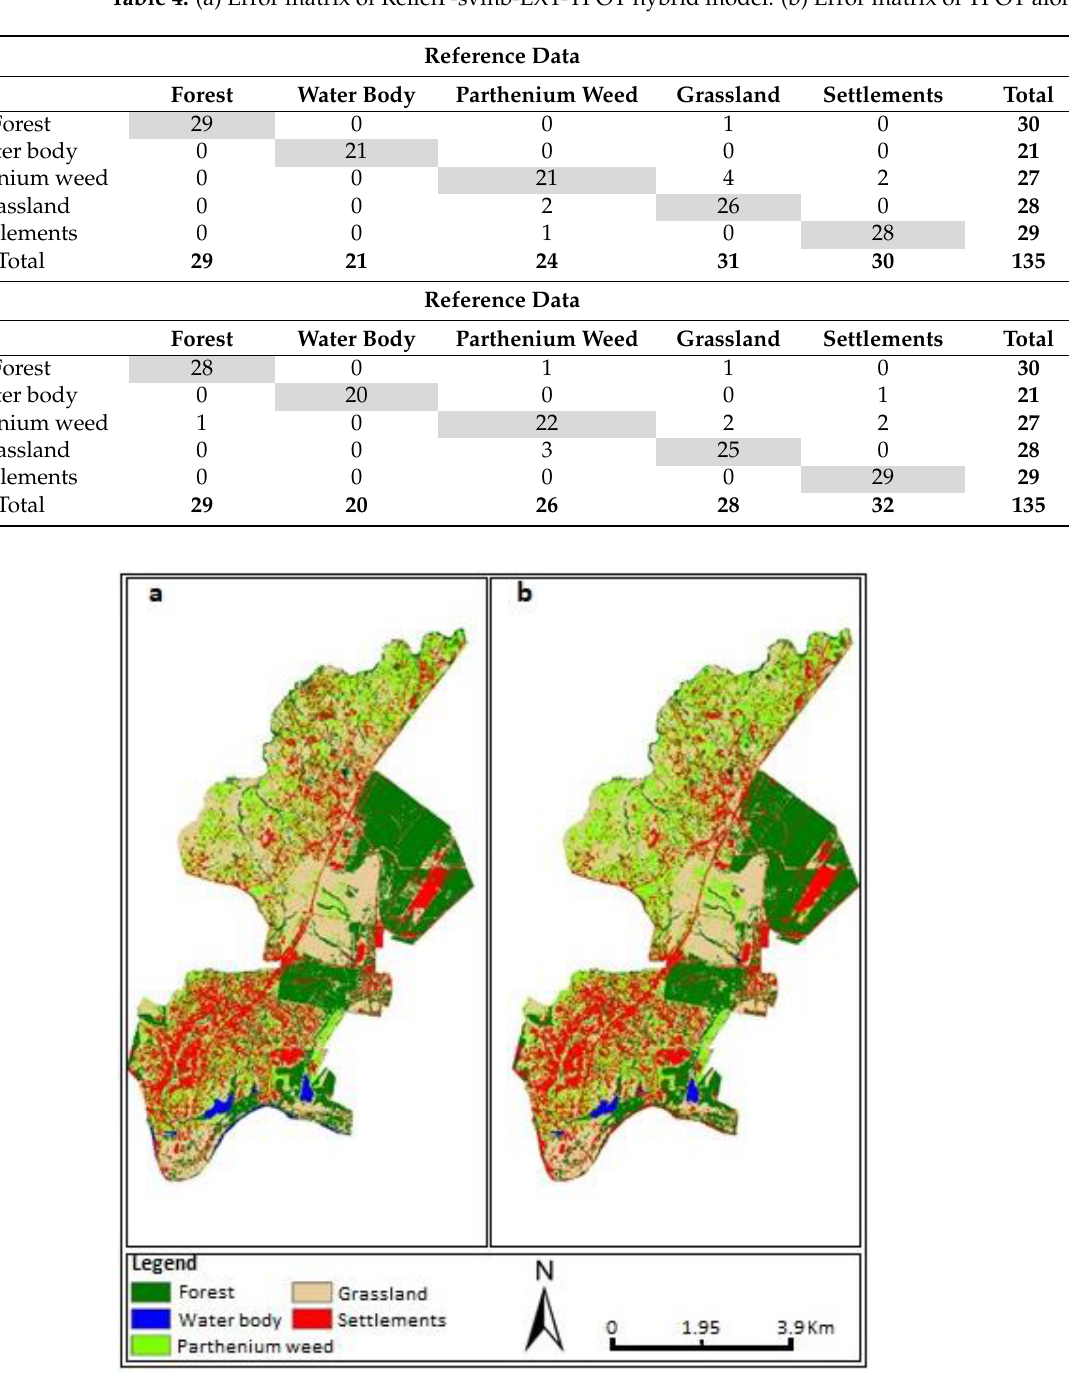
Figure 3. Parthenium weed infestations within coexistent land use/cover types using TPOT models ( a ) and TPOT-Relief-svmb-EXT hybrid models ( b ).